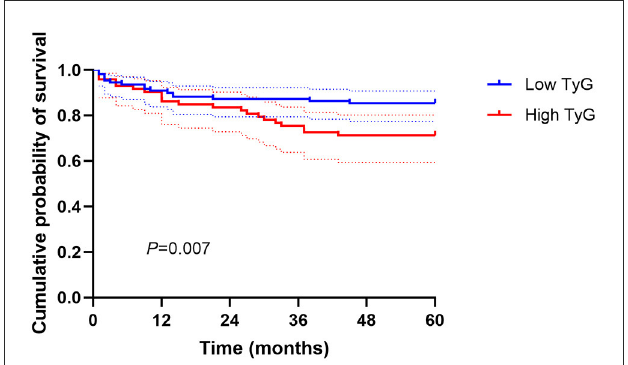
FIGURE1 Kaplan-Meier curves of the cumulative survival probability according to TyG index above and below a cutoff value of